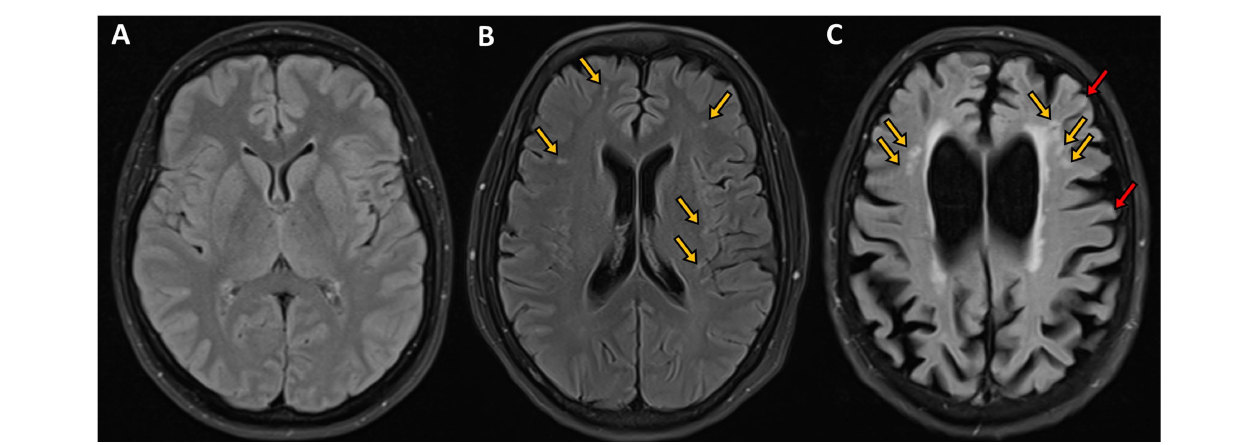
FIGURE 2 | Axial FLAIR images of the brain of subjects with mild cognitive impairment showing (A) normal appearing visualized brain parenchyma with no evidence of ischemia, infarction or microbleeds, (B) bilateral scattered subcortical white matter ischemic changes in the form of hyperintense (bright foci) secondary to microangiopathy shown in orange arrows, and (C) moderate brain atrophy with cortical and subcortical ischemic foci in the form of bright signal intensity shown by orange and red arrows, respectively. Courtesy of Dr. Ahmed Elsotouhy.